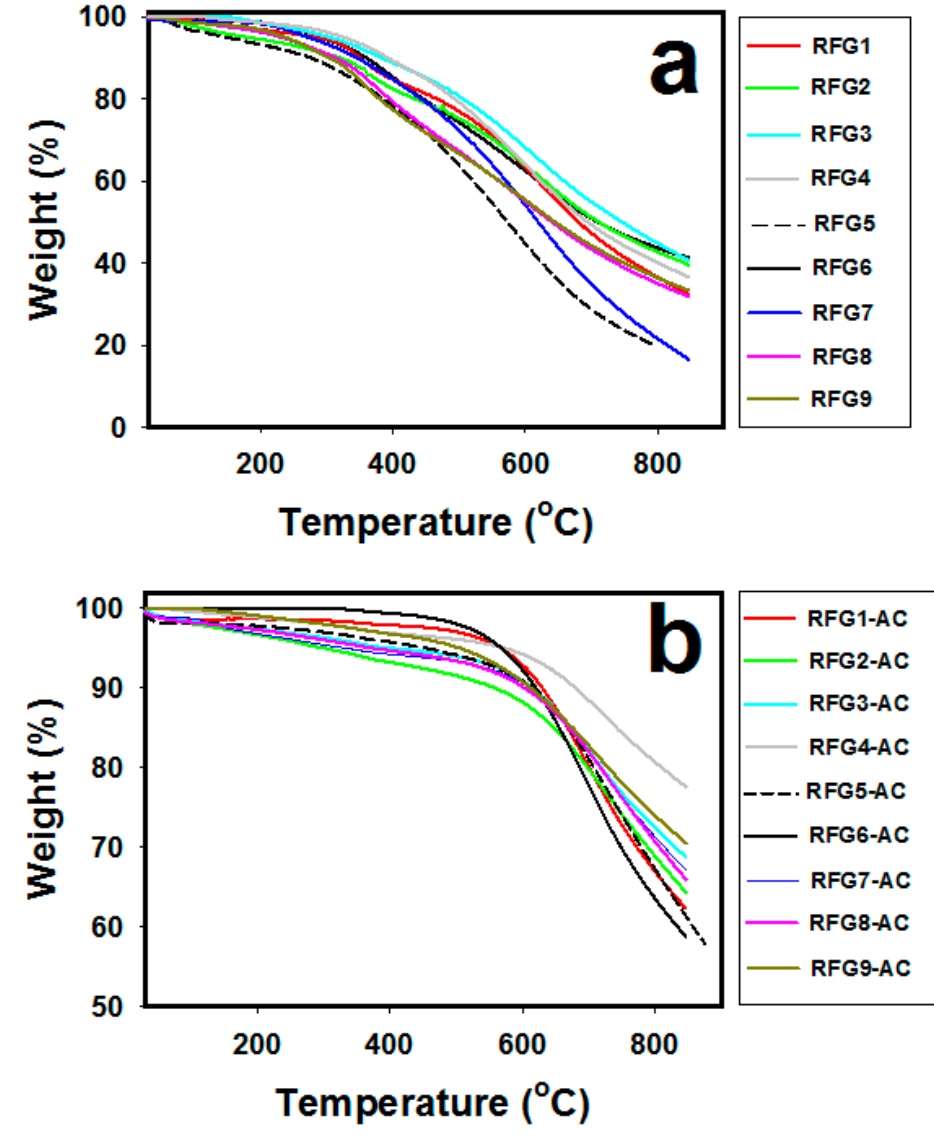
Figure 13. TGA thermograms of ( a ) RFG n and ( b ) RFG n -AC samples.